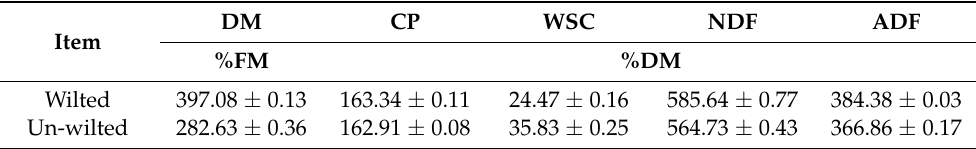
Table 4. Chemical compositions of Stylosanthes prior to